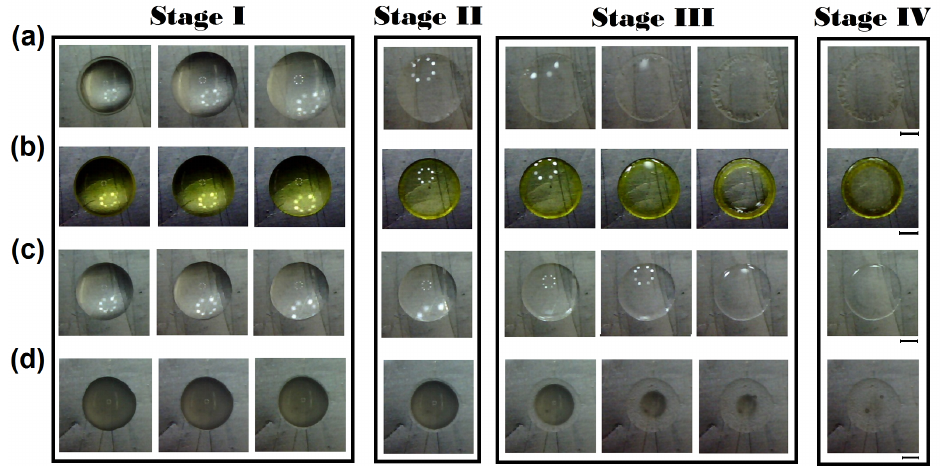
Figure 9. Pattern formation of drug deposits. Pattern formation of ( a ) Clonazepam/NaCl (t = 0, 45, 300, 1650, 1800, 1950, 2100, and 2130 s), ( b ) Methotrexate/NaCl (t = 0, 30, 60, 135, 150, 165, 180, and 240 s), ( c ) Criprofloxacin/NaCl (t = 0, 30, 45, 60, 75, 90, 105, and 150 s), and ( d ) Budesonide/NaCl (t = 0, 30, 45, 60, 105, 165, 180, and 240 s). Labels I, II, and III indicate three stages of formation: increasing in contact area of the droplet, recirculating flow, and the emergence of the stain pattern, respectively. Label IV corresponds to the residual pattern deposit. The diameter of the final deposits are 3.6, 3.15, 3.25, and 3.2 mm, respectively. Pattern formation from the evaporation of droplets was carried out at T s = 63 ◦ C, and RH =